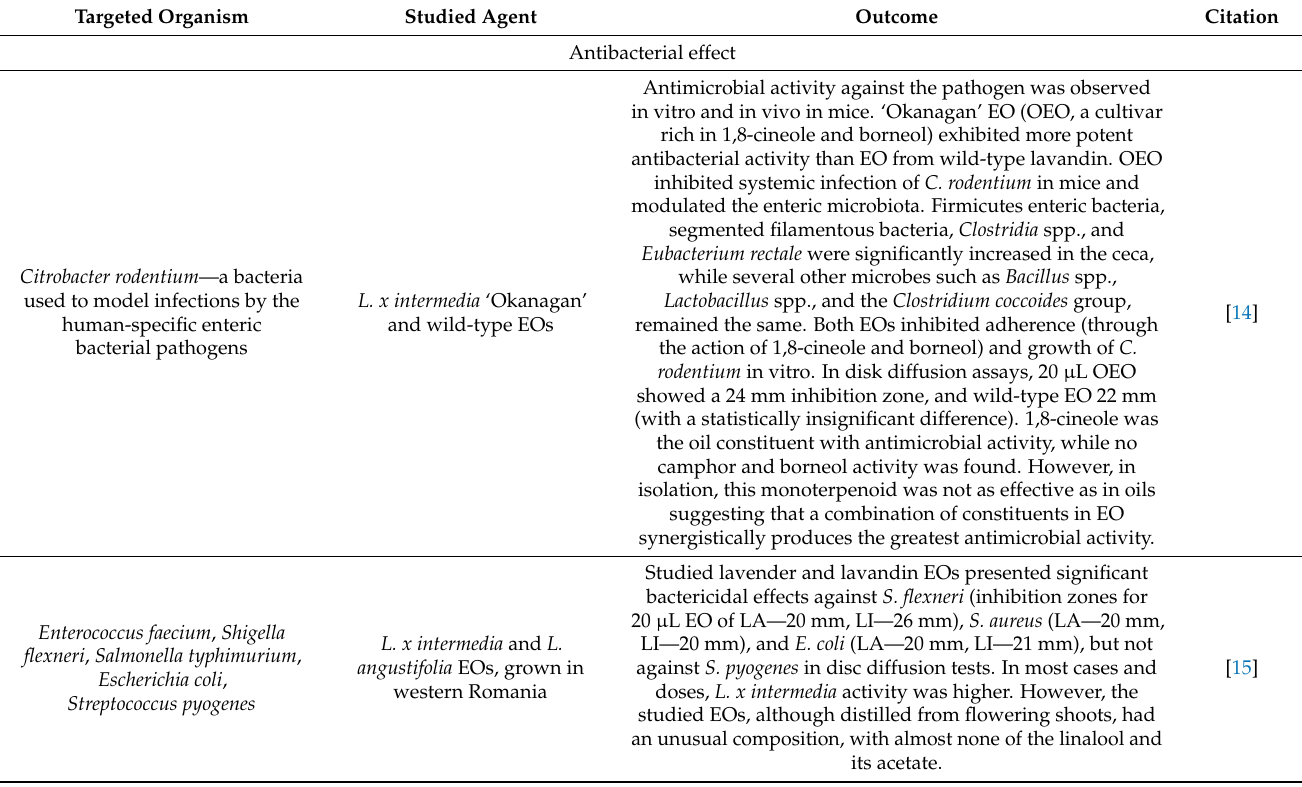
Table 1. The antimicrobial activities of lavandin natural products that are reported in the literature. Only original research articles were